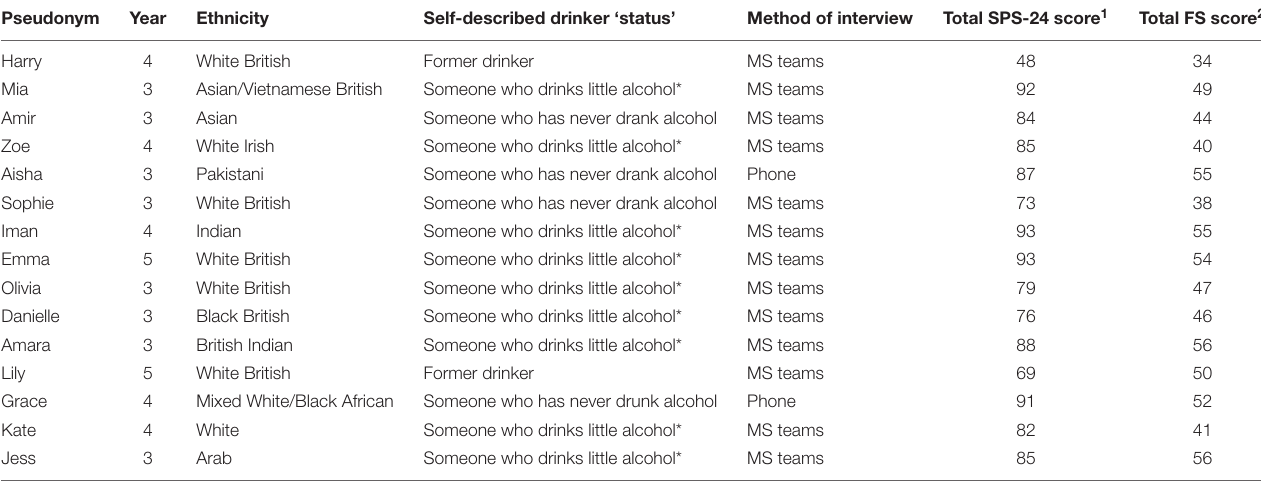
TABLE 1 | Participant demographics including total SPS-24 and FS